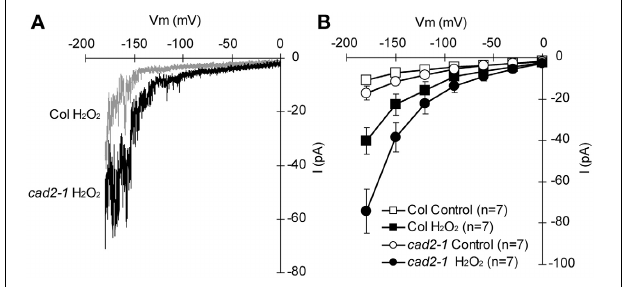
FIGURE 3 | Enhanced activation of cad2-1 I Ca channel currents by H 2 O 2 . (A) Representative current traces of 1mM H 2 O 2 -activated I Ca currents of wild-type GCPs (gray) and cad2-1 GCPs (black). (B) Average current-voltage curves of wild-type GCPs and cad2-1 GCPs as recorded in (A) . A voltage ramp protocol from 0 to − 180mV was used (holding potential, 0mV; ramp speed, 200mV sec − 1 ). GCPs were treated with 1mM H 2 O 2 for 3min before recordings. The bars represent the mean ± SE values of seven independent replicates.